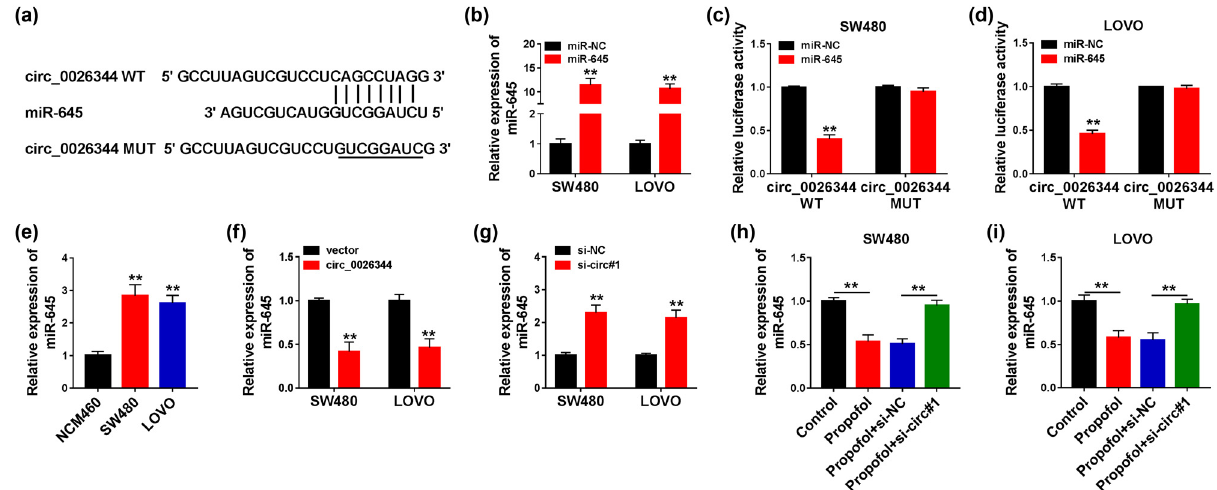
Figure 4: circ_0026344 was associated with miR - 645 in SW480 and LOVO cells. ( a ) Circinteractome online database was employed to predict the putative binding sites of circ_0026344 in miR - 645. ( b ) The transfection e ffi ciency of miR - 645 was determined by qPCR in SW480 and LOVO cells. ( c and d ) Luciferase activities were detected by dual - luciferase reporter assay in SW480 and LOVO cells. ( e ) miR - 645 expression was determined by qPCR in NCM460, SW480, and LOVO cells. ( f and g ) The e ff ects of circ_0026344 overexpression and silencing on miR - 645 expression were revealed by qPCR in SW480 and LOVO cells. ( h and i ) The impacts between propofol treatment and circ_0026344 silencing on miR - 645 expression were demonstrated by qPCR in SW480 and LOVO cells. Signi fi cant di ff erences were compared with Student ’ s t - test ( b, c, d, f, and g ) or ANOVA ( e, h, and i ) . ** P <